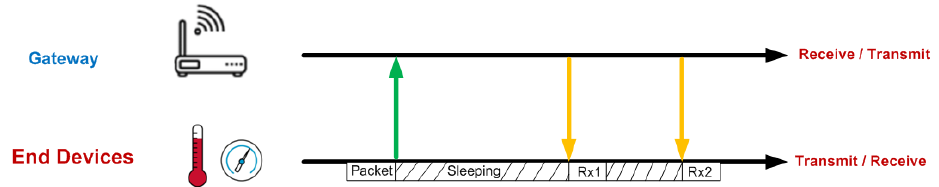
Figure 3. Class A